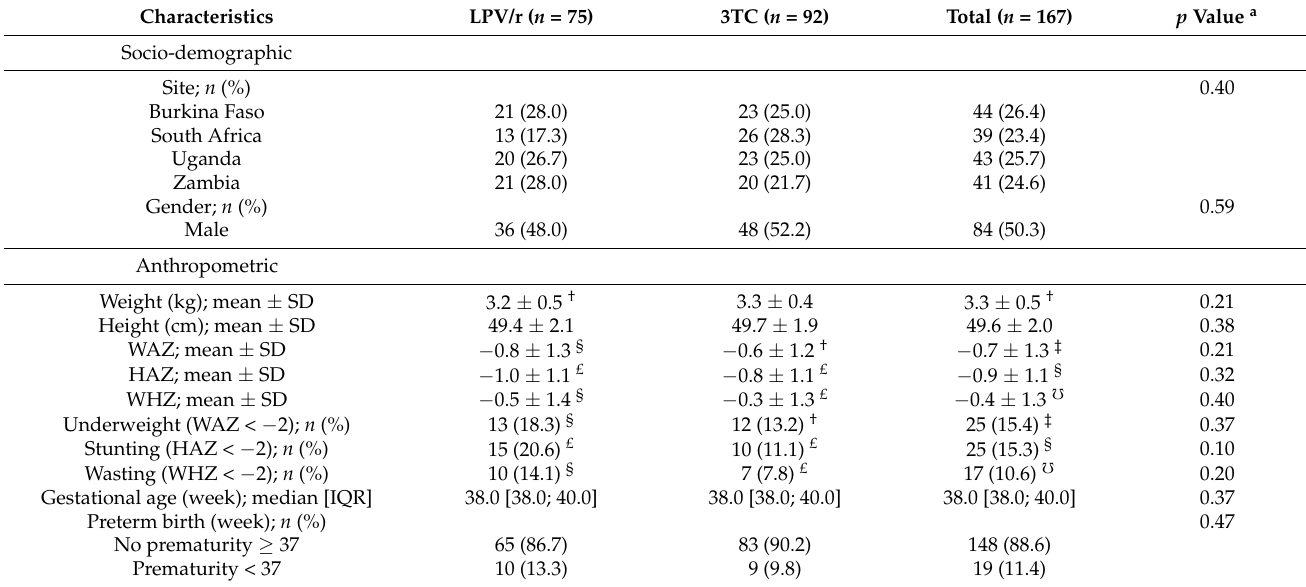
Table 1. Children’s characteristics at randomization